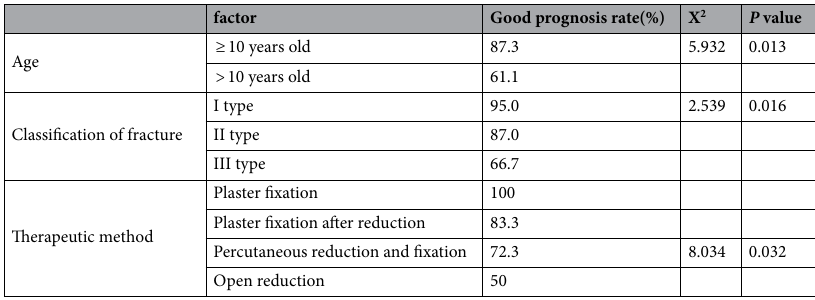
Table2. Univariate analysis of poor prognosis in children with radial neck fracture.